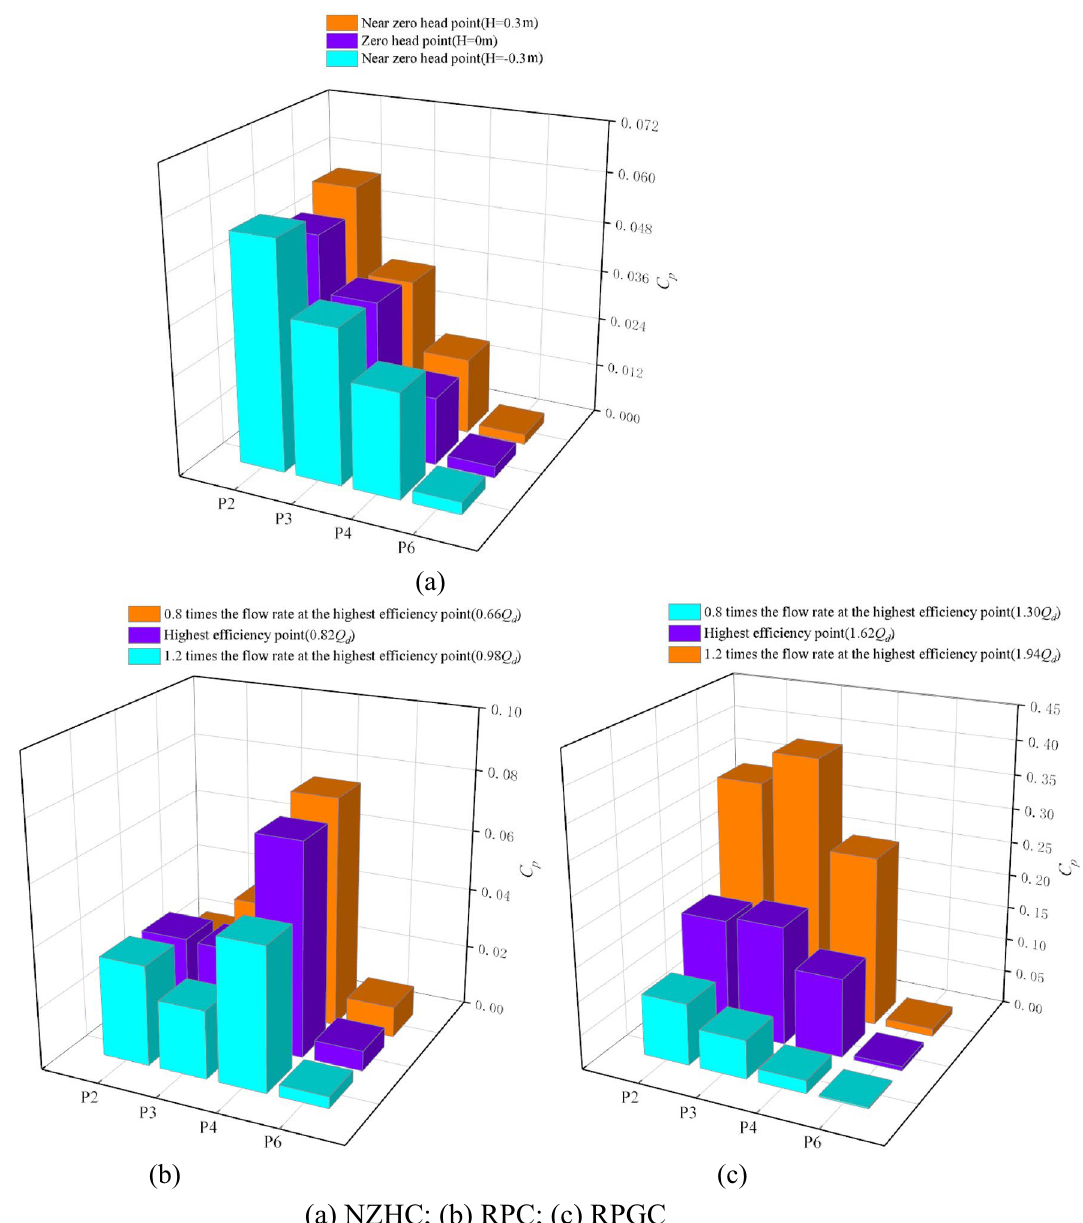
Figure 15. Main frequency amplitudes of monitoring points under special utilization